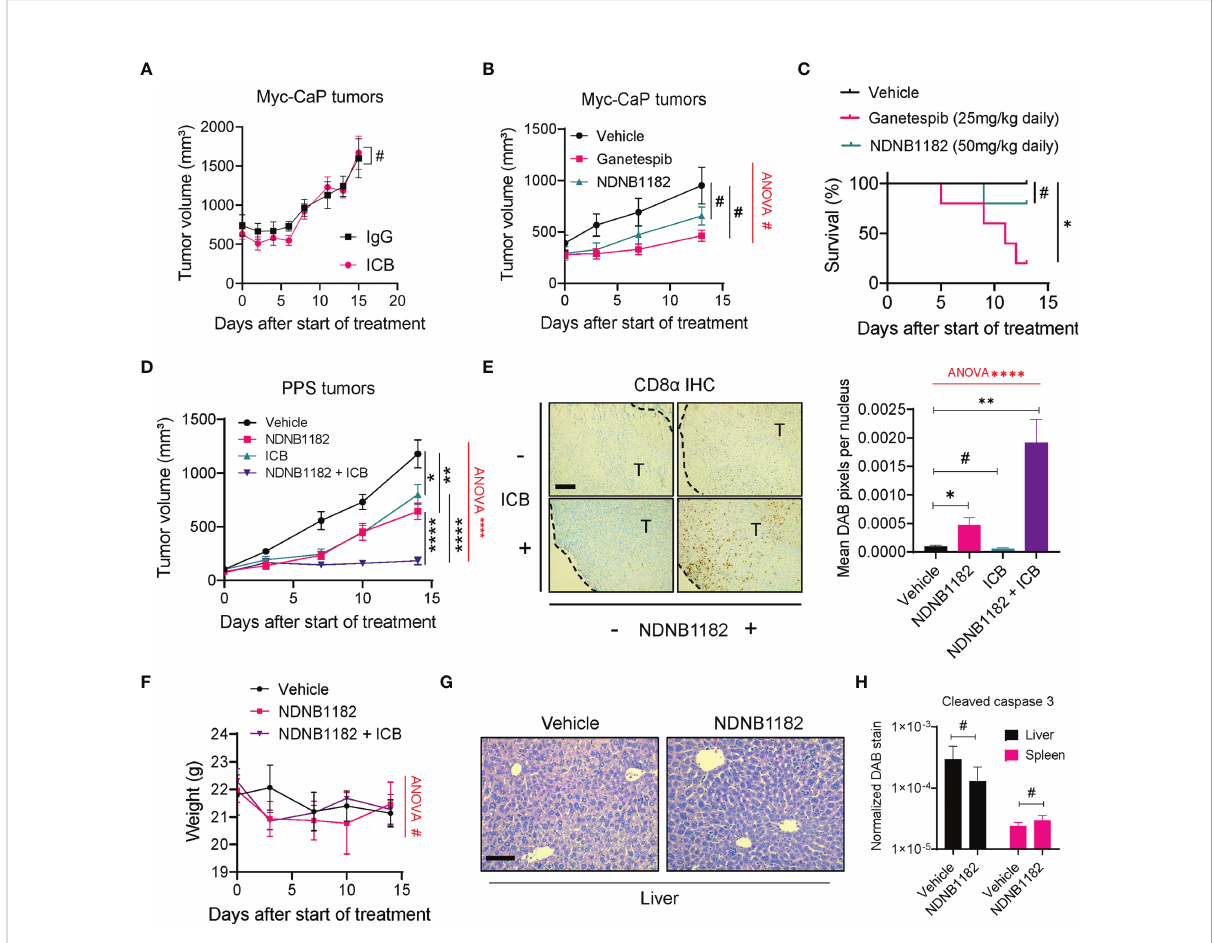
FIGURE 3 NDNB1182 enhanced ICB ef fi cacy in the PPS syngeneic prostate cancer model. (A) Growth curves of Myc-CaP tumors treated with isotype IgG or ICB (anti-PD1 plus anti-CTLA4) administered intraperitoneally (i.p.) at 10mg/kg, twice/week. N=9/group. (B) Growth curves of Myc-CaP tumors treated with vehicle, Ganetespib (25mg/kg, i.p. daily) or NDNB1182 (50mg/kg, i.p. daily). N=10 tumors/group at the start of the treatment. (C) Survival curves for mice bearing Myc-CaP tumors and treated with vehicle, Ganetespib or NDNB1182. N=5/group. (D) Growth curves of PPS tumors treated with vehicle control (N=6), NDNB1182 (50mg/kg, i.p. daily; N=6), ICB (anti-PD1 plus anti-CTLA4, 10mg/kg, i.p., twice/week; N=10), or concurrent NDNB1182 plus ICB (N=8). In (A, B, D) , the randomized groups on day 0 of the treatment showed no signi fi cant difference based on statistical tests (for (A) two groups at day 0, P=0.8238 based on Mann Whitney test; for (B) three groups at day 0, P=0.4265 based on ANOVA test; for (D) four groups at day 0, P= 0.5561 based on ANOVA test). (E) Representative images and quanti fi cation results for CD8 a immunohistochemistry on PPS tumors treated with the four regimens. The tumor regions ( “ T ” ) and the margin contours are denoted. N=5 for each condition. Image analysis and quanti fi cation was performed with ImageJ following a published protocol (59), where DAB signals were normalized to the number of nuclei present in the images. Scale bar 200µm. (F) Body weight changes of mice treated with vehicle, NDNB1182, or NDNB1182 plus ICB. (G) Representative H&E staining images of liver from vehicle-treated and NDNB1182-treated mice. Scale bar 50µm. (H) Quanti fi cation results for cleaved caspase 3 immunohistochemistry on liver and spleen tissues from vehicle-treated and NDNB1182- treated mice. In (A – H) , data represent mean ± SEM. #P>0.05; *P<0.05, **P<0.01, ****P<0.0001, Student ’ s t-test. In (B, D – F) , one-way ANOVA test result was shown in red (#P>0.05; ****P<0.0001). In (C) , #P>0.05; *P<0.05, logrank